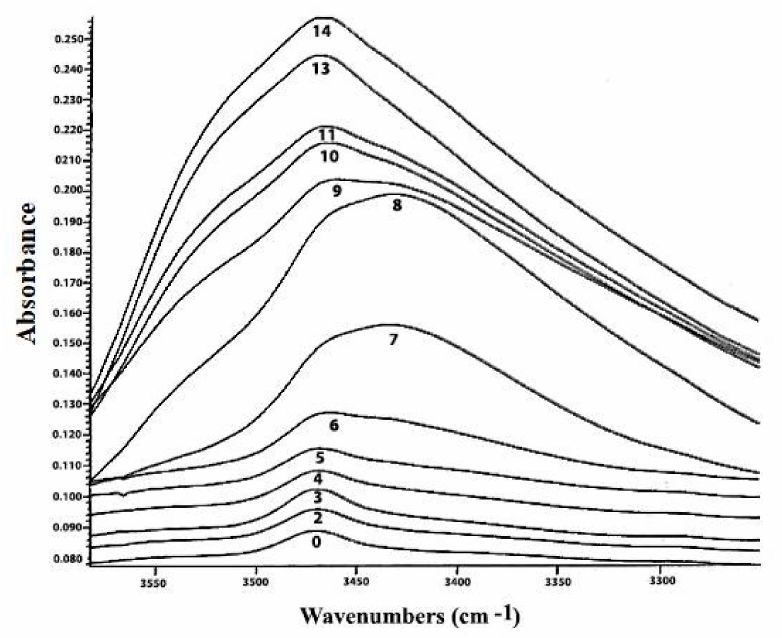
Figure 6. IR spectral changes in the region 3600–3250 cm − 1 of sunflower oil on different days (0 to 14) of the oxidation process. Adopted with permission from [39]. Copyright 2007, American Chemical